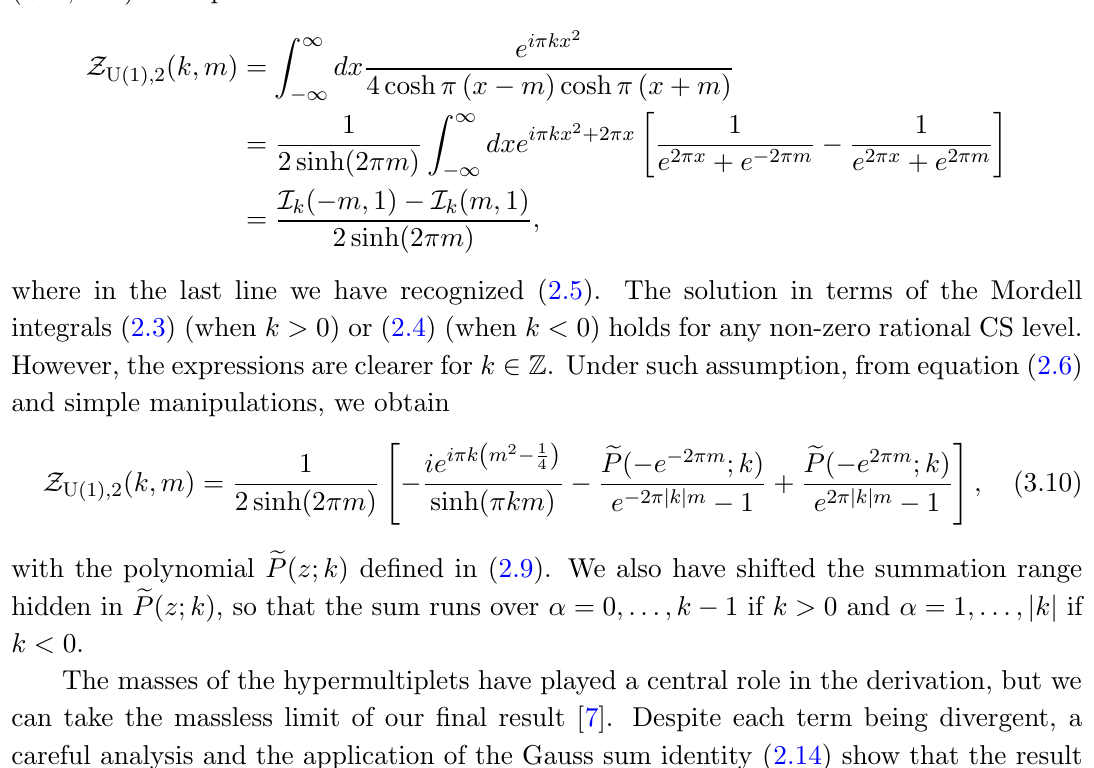
Figure 6 . Abelian A 1 quiver with N f = 2 fundamental